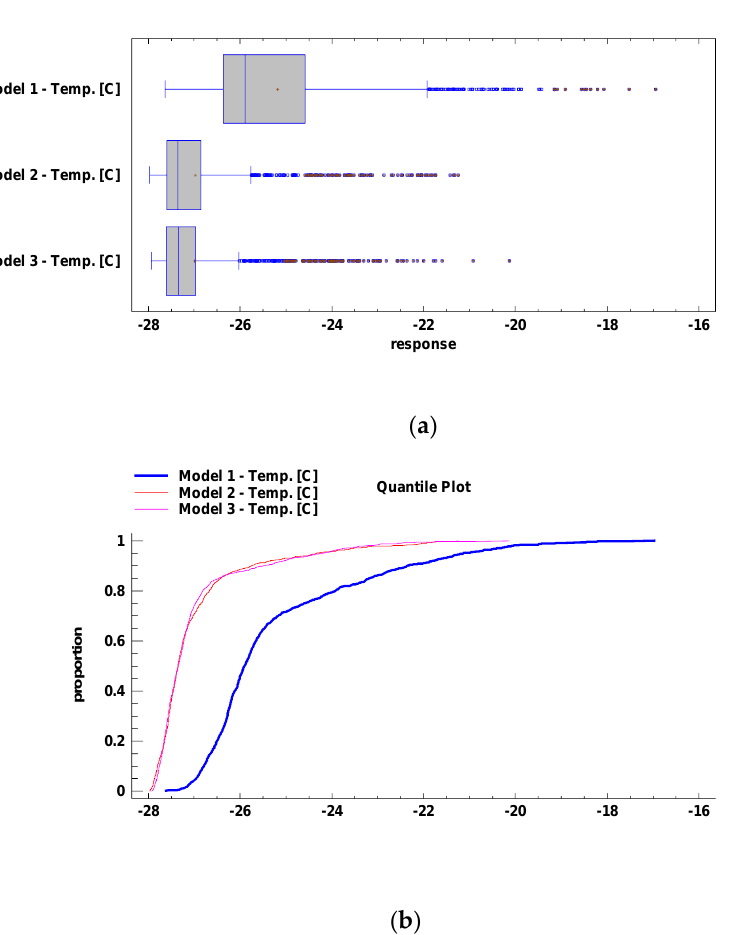
Figure 9. ( a ) Box-and-whisker plots of the temperature distributions of Models 1, 2, and 3, ( b ) quantile plots of the temperature proportions of Models 1, 2, and